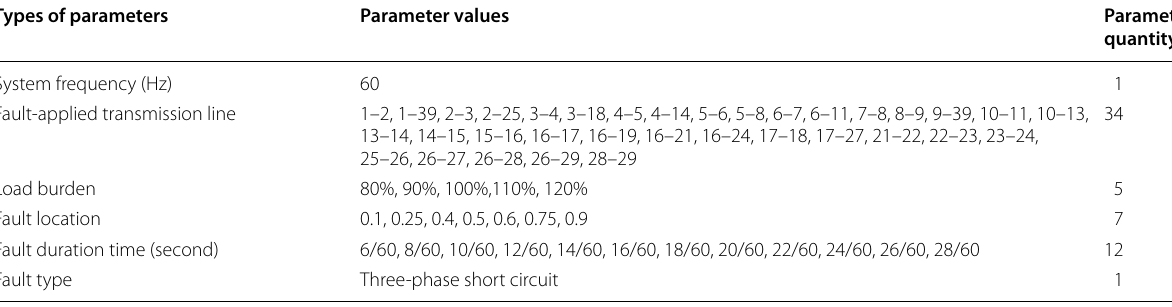
Table 8 The parameter setting of PSS/E batch transient simulation on the IEEE 39-bus system